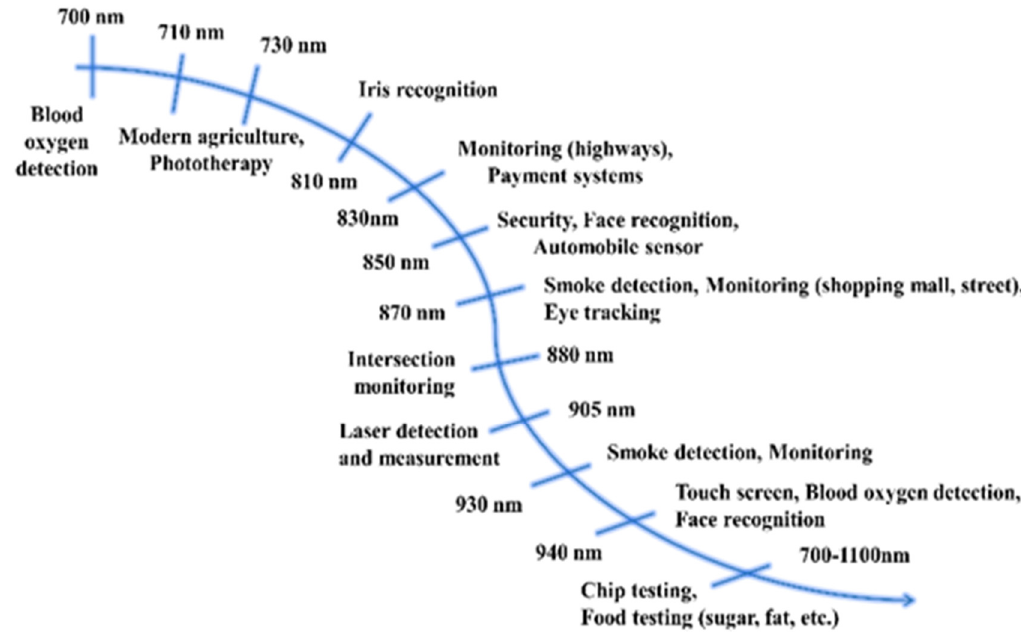
Figure 1. Applied analysis of far-red/NIR light .